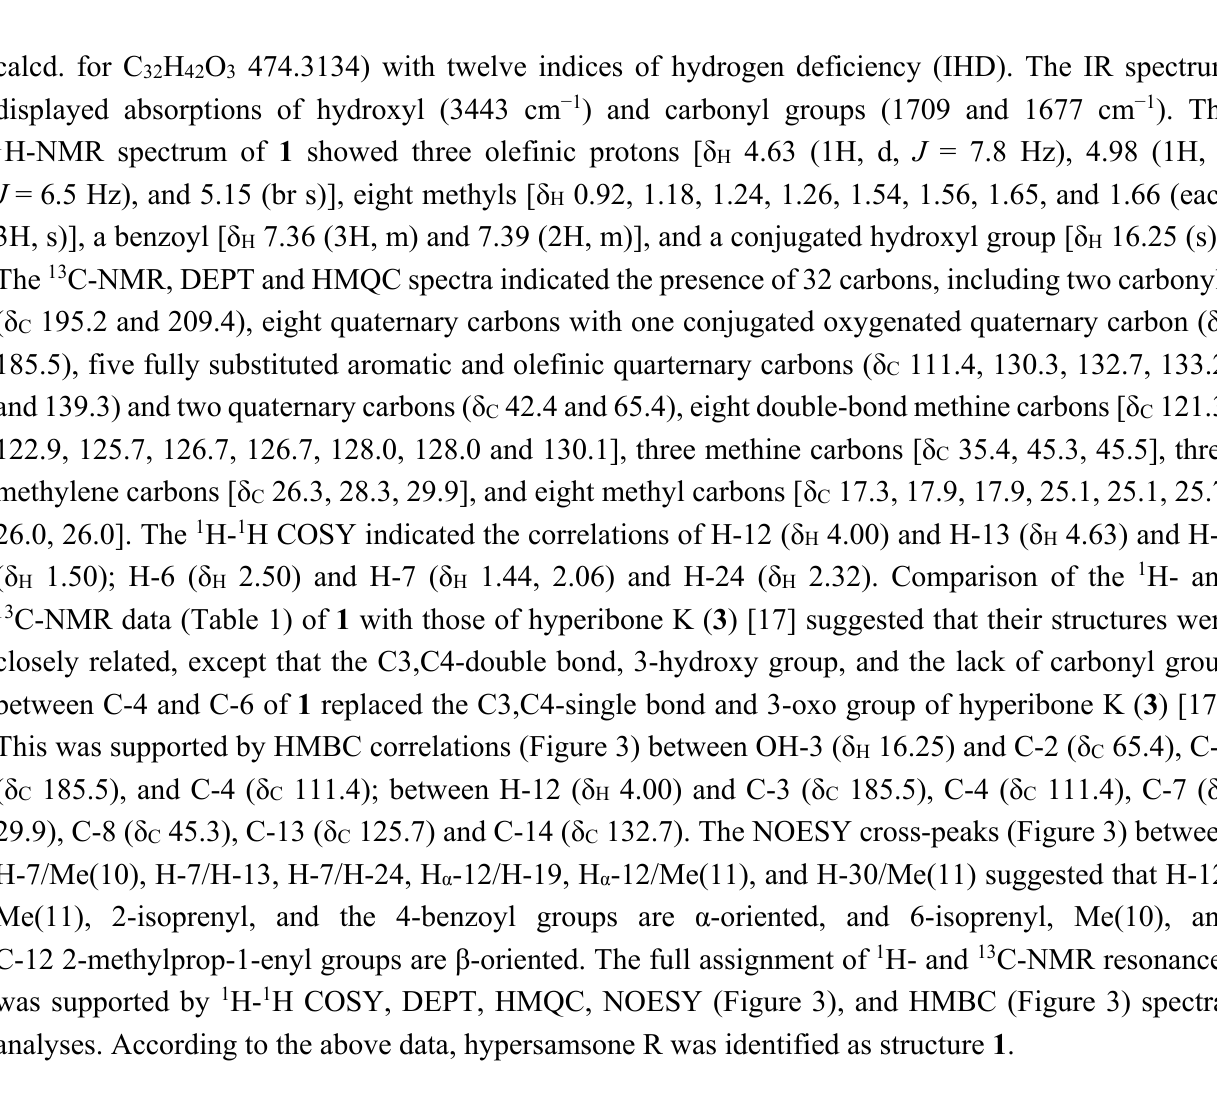
Figure 3. Key NOESY ( a ) and HMBC ( b ) correlations of 1